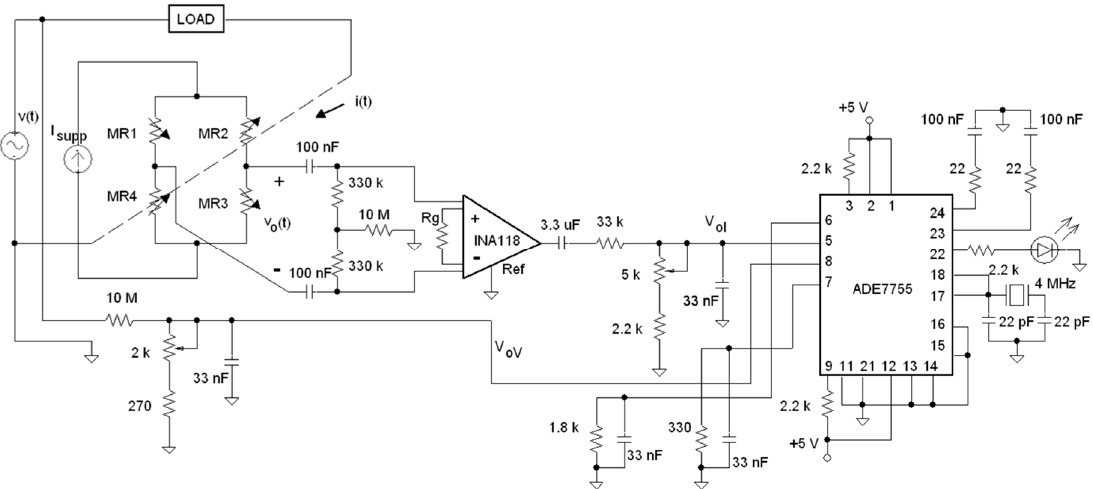
Figure 11. Whole schematic circuit that constitutes the TMR-based energy meter.